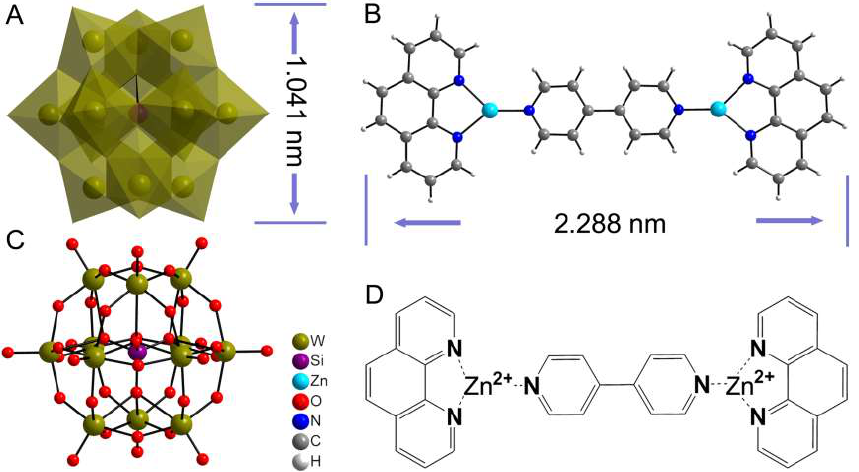
Figure 1. ( A ) Polyhedral view of the [SiW 12 O 40 ] 4– unit; ( B ) ball-and-stick view of the binuclear copper complex [Zn 2 (4,4′-bpy)(Phen) 2 ] 4+ ; ( C ) ball-and-stick view of the [SiW 12 O 40 ] 4– unit; ( D ) structural diagram of [Zn 2 (4,4′-bpy)(Phen) 2 ] 4+ in [Zn 2 (4,4′-bpy)(Phen) 2 ][SiW 12 O 40 ] (ZSW).